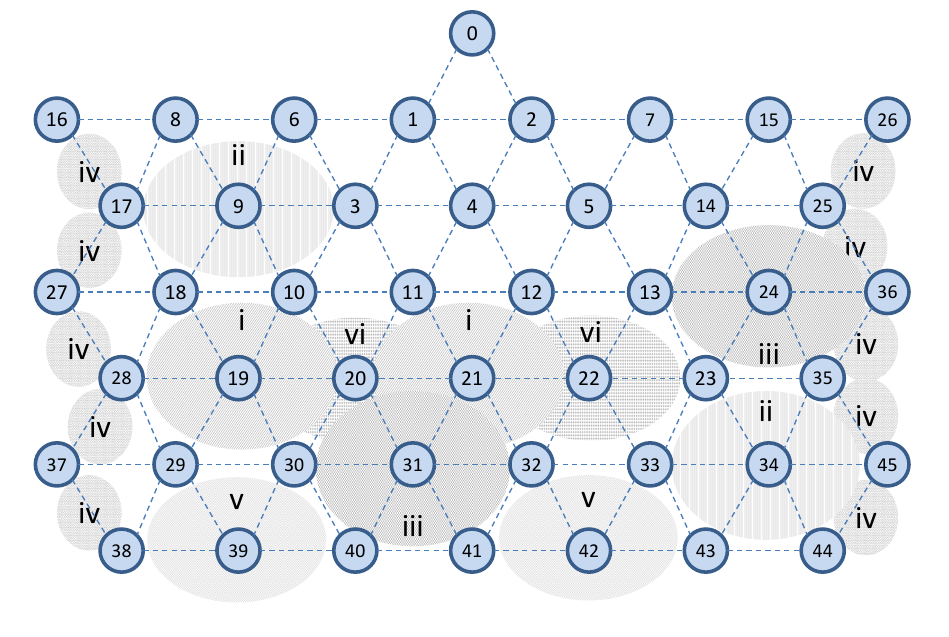
Figure 26. Applying interference incrementally in six steps.